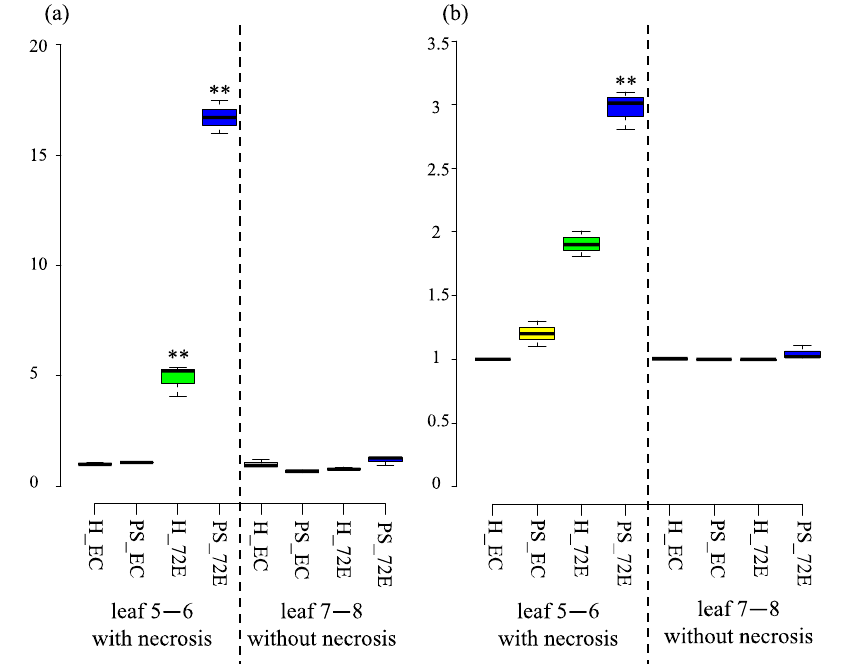
Figure 9. Relative ROS production ( a ) and relative ROS scavenging activity ( b ) in the leaves 5 and 6 (with necrosis) and leaves 7 and 8 (without necrosis). An unusually high level of ROS production and scavenging activity was found in leaves 5 and 6, showing necrosis in PSTVd-72E (PS_72E) compared with healthy-EC (H_EC) plants. A relatively high level of ROS production and scavenging activity was also detected in the leaves 5 and 6 of healthy-72E (H_72E) plants. Leaves of the same plants as described above were used for the analysis. The assay was repeated twice, and each analysis consisted of three biological replicates collected randomly from five plants per treatment. The center lines show the medians; the box limits indicate the 25th and 75th percentiles as determined using R software; the whiskers extend 1.5-times the interquartile range from the 25th and 75th percentiles; the dots represent outliers. The values with the double asterisk (**; p < 0.01) was statistically significant at 1% level compared to